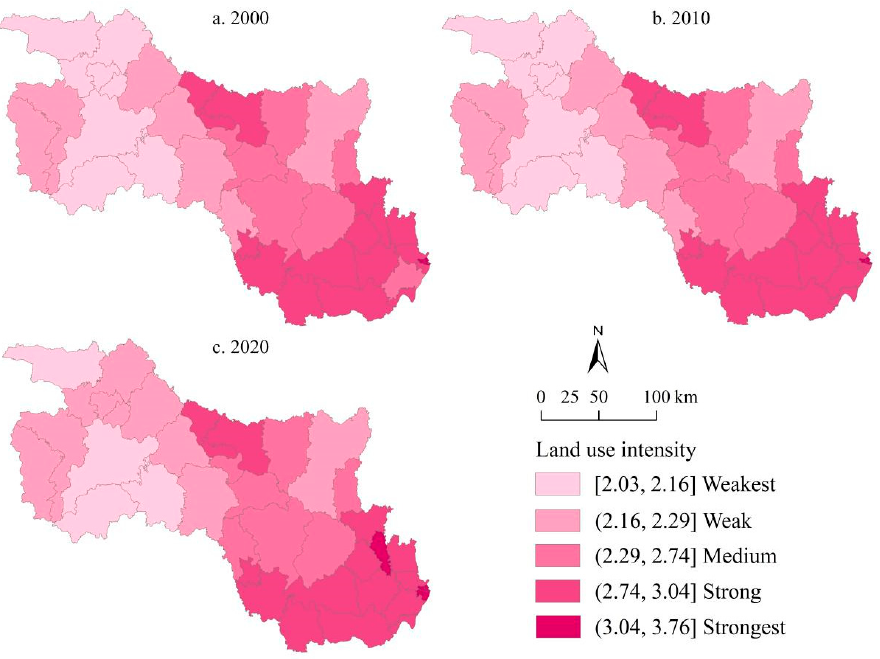
Figure 3. The spatial pattern of land use intensity in the HRB of Hubei Province for ( a ) 2000; ( b ) 2010;